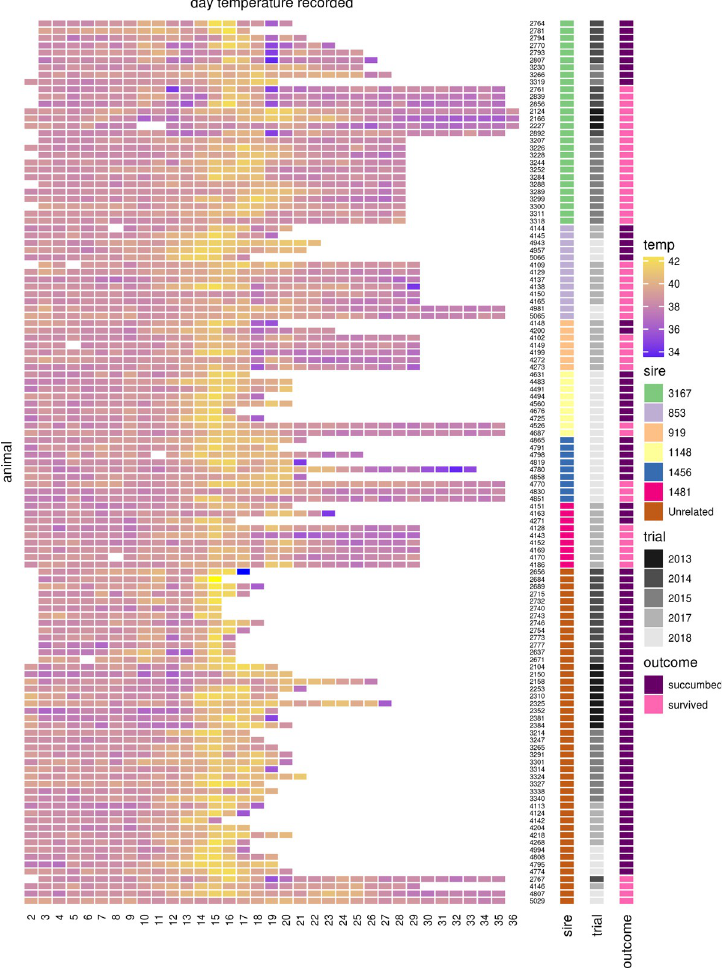
Fig 1. Heatmap of daily body temperature (˚C) recordings throughout the field trials. Animals 853, 919, 1148, 1456 and 1481 were all male progeny of sire 3167. Temperature observations commenced on day 2.